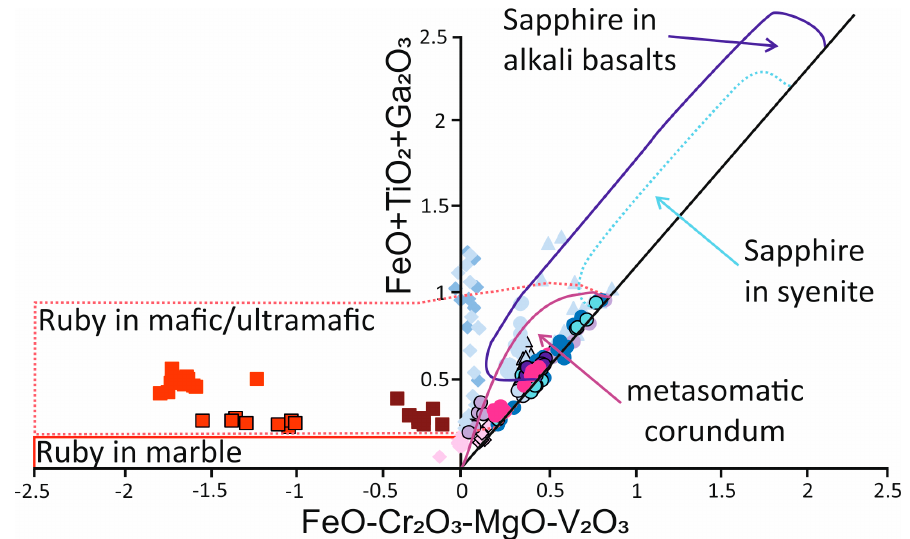
Figure 10. Greek corundum LA-ICP-MS analyses plotted on a FeO–Cr 2 O 3 –MgO–V 2 O 3 versus FeO + TiO 2 + Ga 2 O 3 discrimination diagram after Giuliani et al. [87,88]. Symbols as in Figure 9.